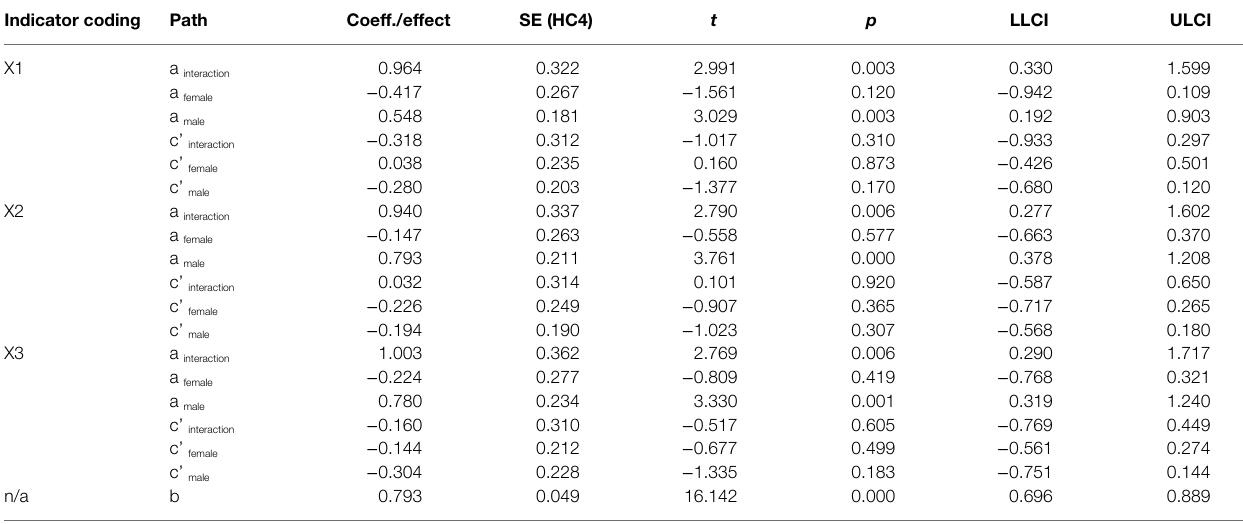
TABLE 2 | Moderated mediation table for the effect of the finance coach type through autonomy satisfaction, moderated by user gender, on Intention to Use. Indicator coding Path Coeff./effect